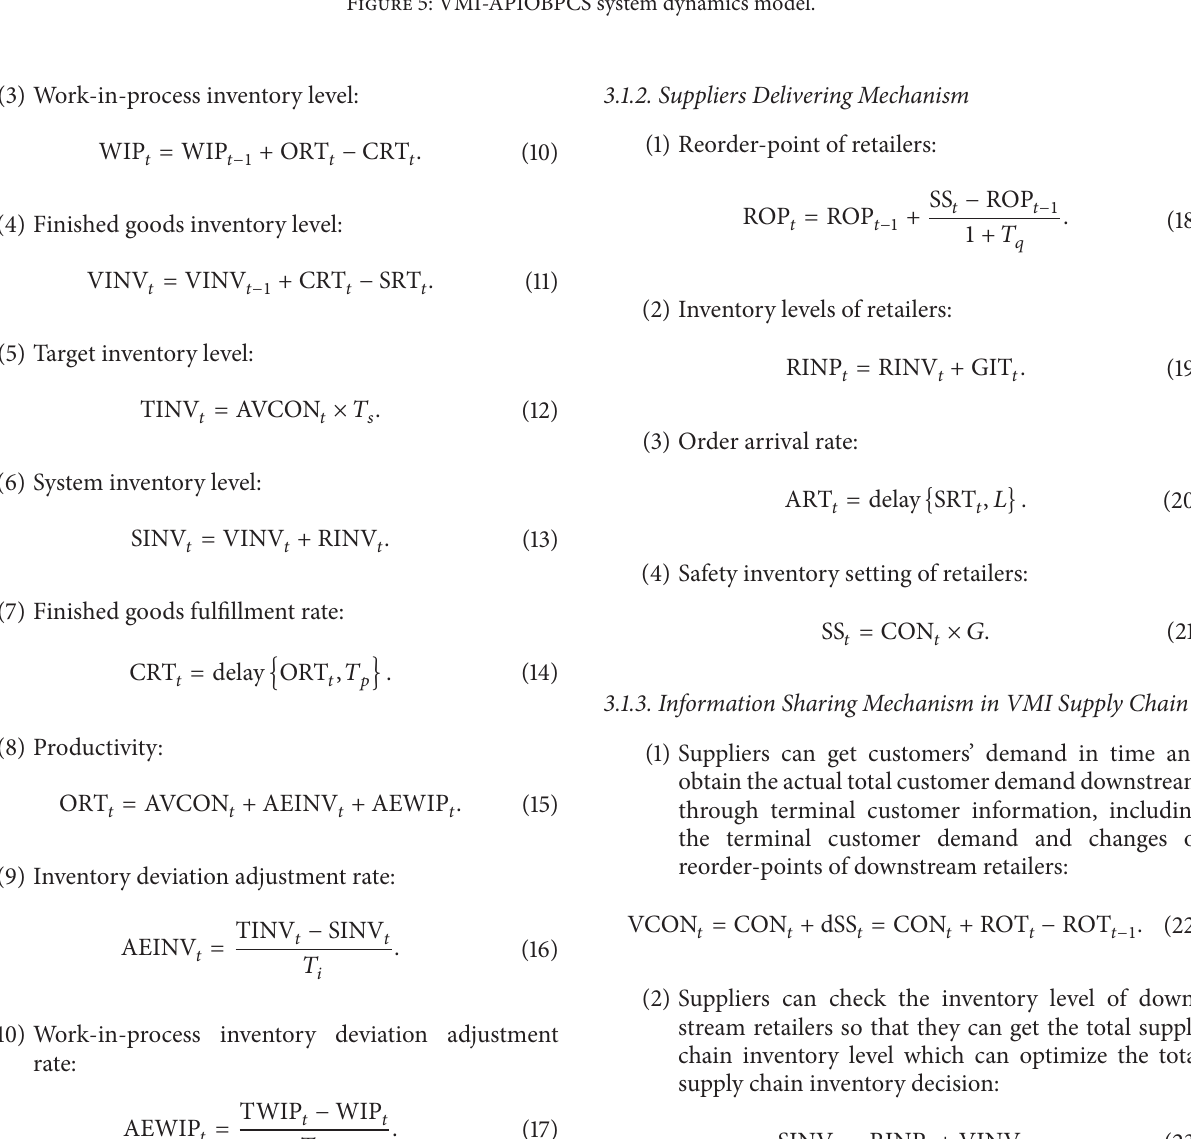
Figure 5: VMI-APIOBPCS system dynamics